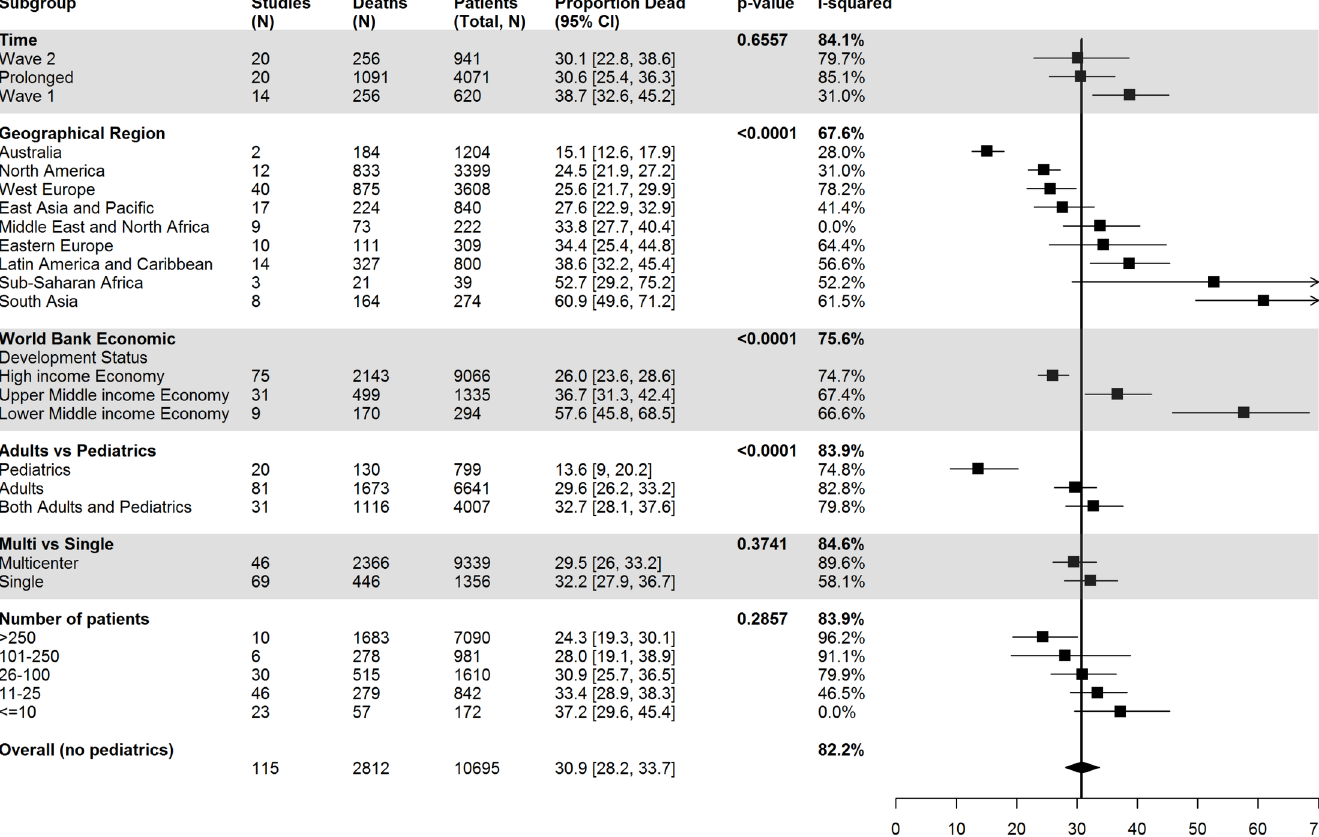
Fig 2. Reported mortality associated with 2009 Influenza A (H1N1) associated critical illness. We describe the mortality based on temporal (early, late and prolonged enrollment), study (study size, single center compared to multicenter and adults compared to pediatrics), and the geographic location and socioeconomic development from the included studies. The black squares represent the point estimate and 95% confidence intervals (CIs) around the mortality for each subgroup. The black diamond is the summary or overall combined estimate of mortality associated with the 2009 Influenza A (H1N1)